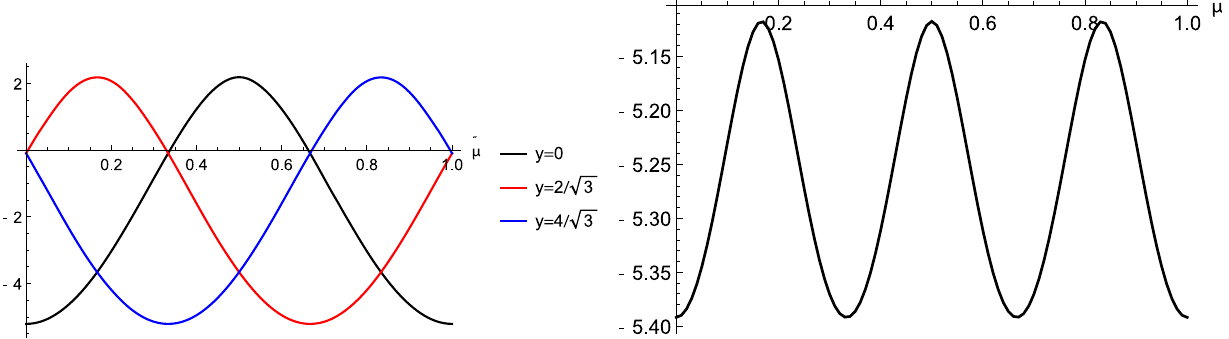
, ˜ μ = 2 . The left panel is the same as the right panel in Fig.2 3 3